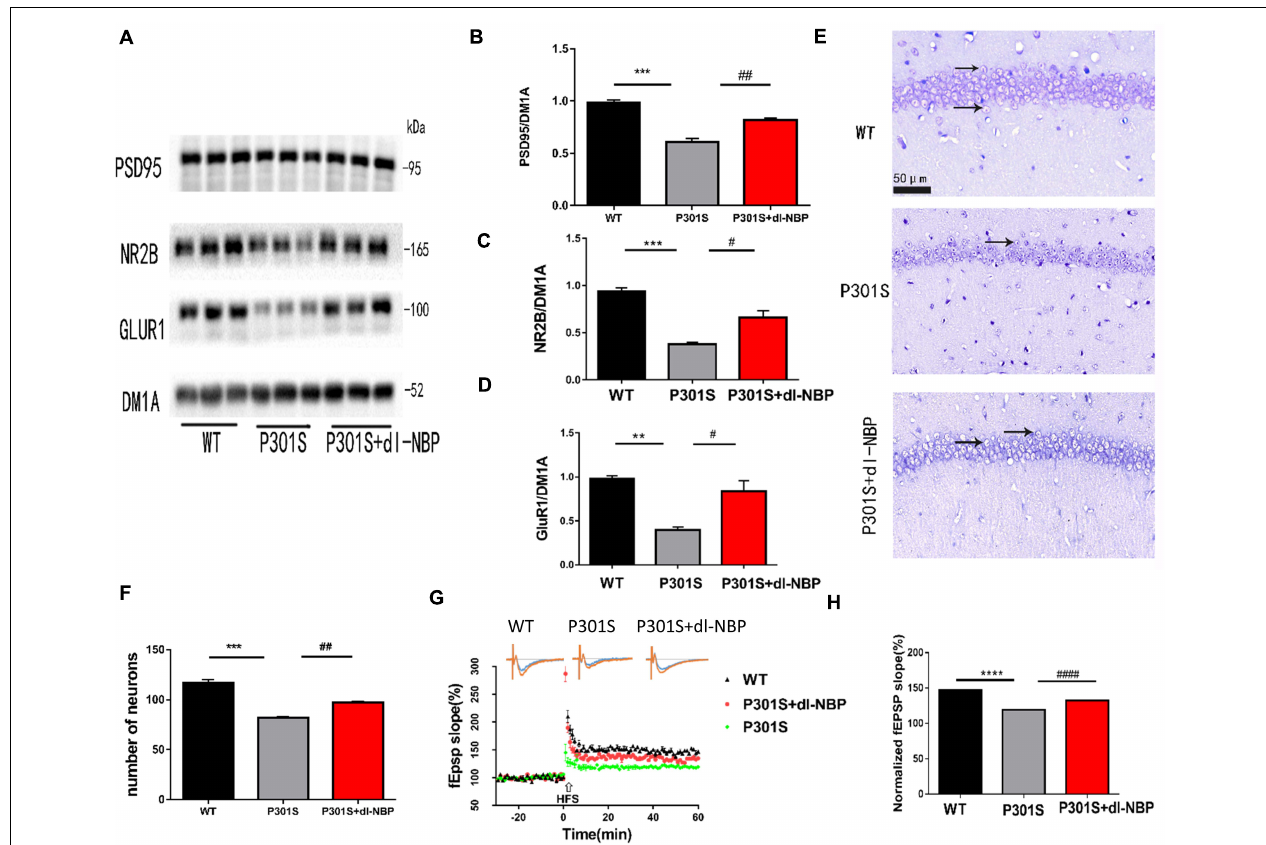
FIGURE 3 | dl-NBP rescued synaptic loss in P301S mice. (A) Representative western blots of synaptic plasticity-related proteins GLUR1, NR2B, and PSD95 of the hippocampus from three groups. DM1A was shown as a loading control. (B–D) Quantitative analysis of GLUR1, NR2B, and PSD95/DM1A ratio. (E) Representative Nissl staining sections of the hippocampal CA1 region. Scale bars: upper panel—500 µ m, lower two panels—50 µ m. (F) Quantitative analysis of surviving neurons in the region of CA1. (G,H) The slope of fEPSP after high-frequency stimulation (HFS) recorded on hippocampal slices of the three groups. LTP magnitude was calculated as the average (normalized to baseline) of the responses recorded 40–60 min after conditioning stimulation. All results were presented as mean ± SEM ( n = 5). ** P < 0.01, *** P < 0.001, **** P < 0.0001, WT mice vs. P301S mice; # P < 0.05, ## P < 0.01, #### P < 0.0001, P301S mice vs. P301S + dl-NBP